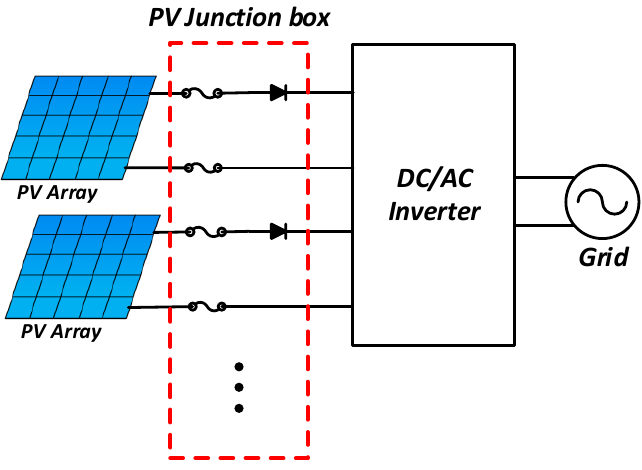
Figure 1. The conventional PV junction box configuration in a PV system.